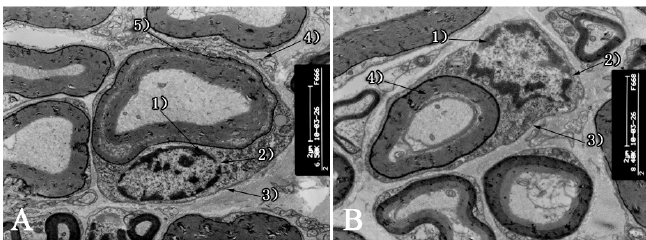
FIGURE 6 – A. Ultramicrostructure of nerves at the anastomotuc